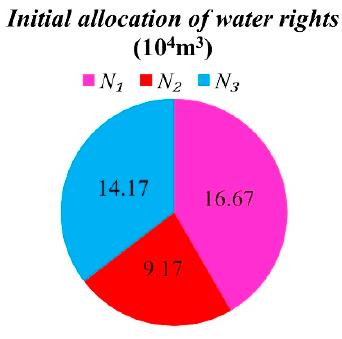
Figure 3. Initial allocation of water rights.